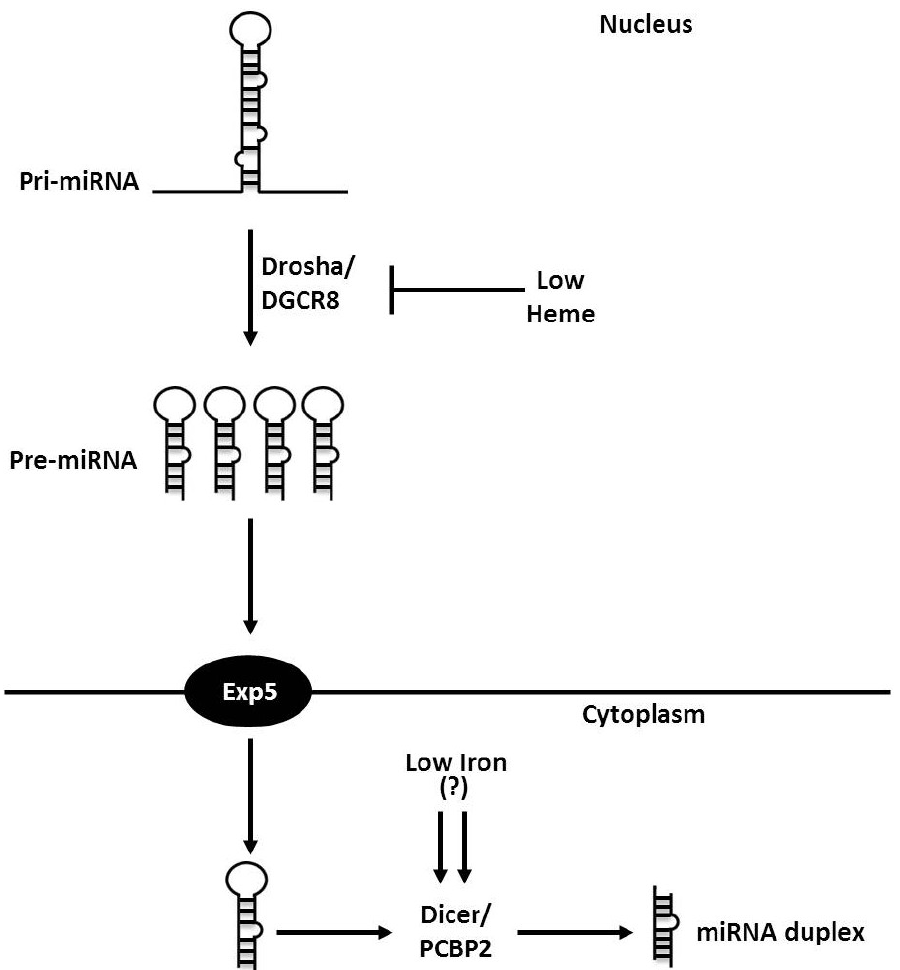
Figure 1. Relationship between cellular iron and miRNA processing. Following their transcription, primary miRNA (pri-miRNA) are cleaved at the stem of the hairpin structure by the RNase II-type protein Drosha and its cofactor DGCR8, a heme-binding protein. Heme-free DGCR8 is less active than heme-bound DGCR8 suggesting that cellular iron status may affect the rate and efficiency of pri-miRNA processing. The product of Drosha/DGCR8 processing is an ~70 nucleotide long precursor miRNA (pre-miRNA) that is exported out of the nucleus into the cytoplasm by the nuclear export factor exportin 5 (Exp5) through the recognition of a short 3′-overhang on the pre-miRNA. Upon entry into the cytoplasm, the RNase III-like enzyme Dicer catalyzes the second processing step of “dicing” the pre-miRNA to produce an ~22 nucleotide long miRNA duplex. Preliminary evidence suggests that iron also regulates the processing of pre-miRNA via the iron-dependent regulation of Dicer activity through its association with poly(rC)-binding protein 2 (Pcbp2), wherein the removal of cytosolic iron, but not heme-iron, enhances pre- miRNA processing. Following cleavage by Dicer, the miRNA duplex is available to be assembled into the RISC to participate in RNA silencing of target